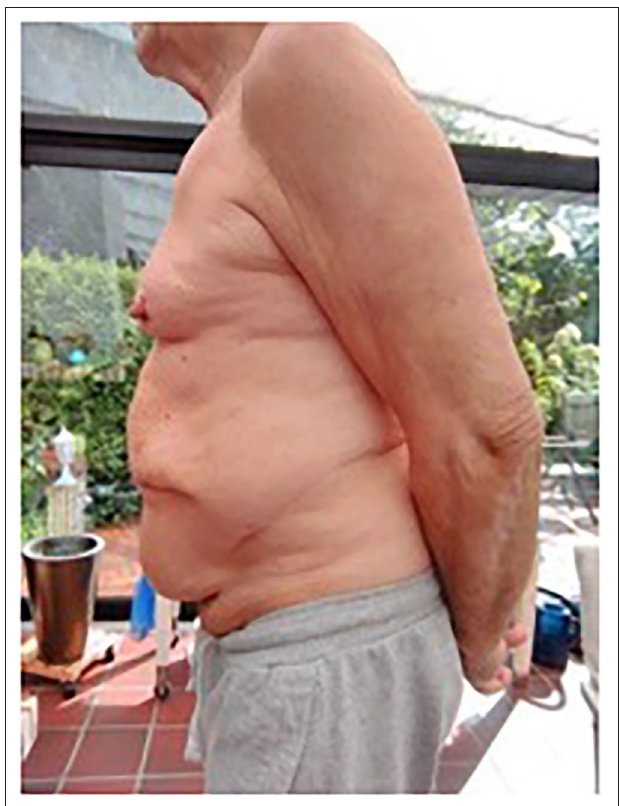
FIGURE 9 | Patient 2 postoperative: lateral view of patient, private archive: Prof. Dr. H. Niebuhr 10.